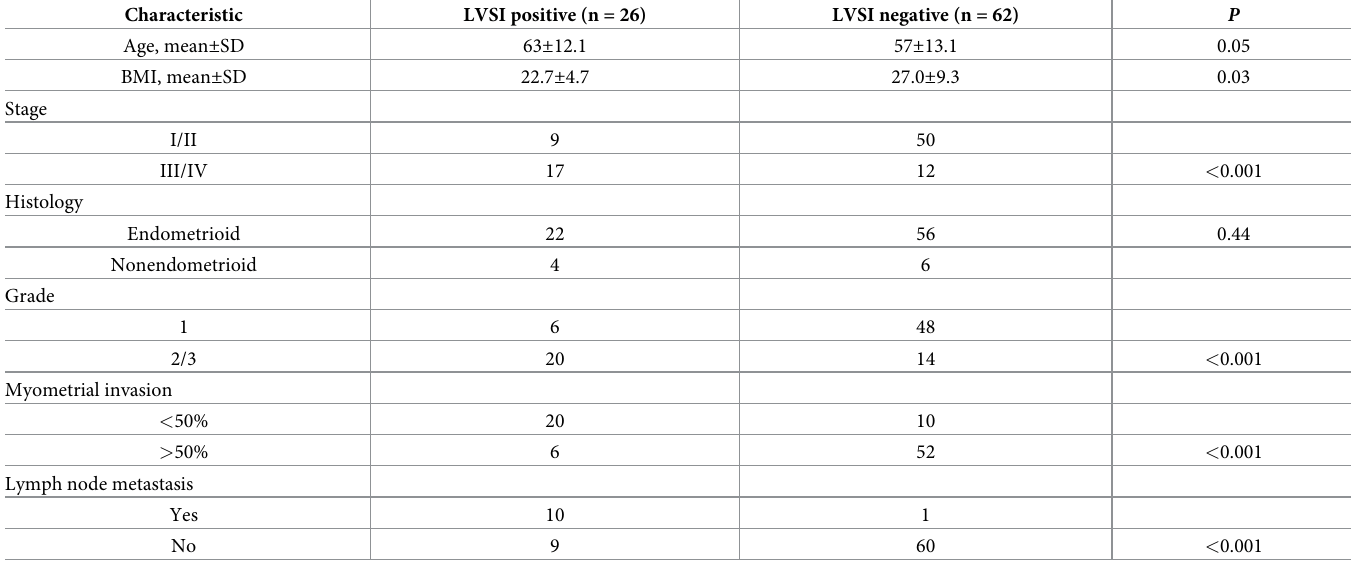
Table 1. Clinicopathological characteristics of LVSI positive and negative